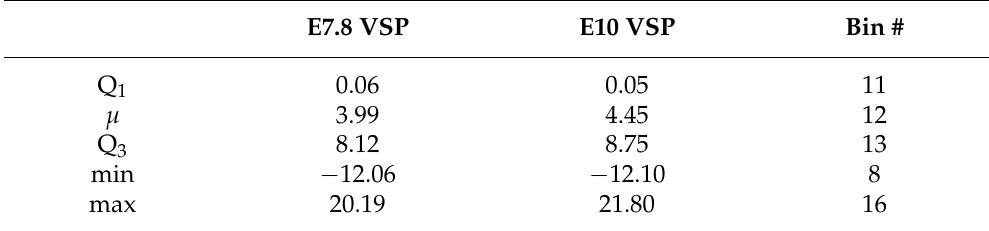
Table 7. VSP bin for main statistic